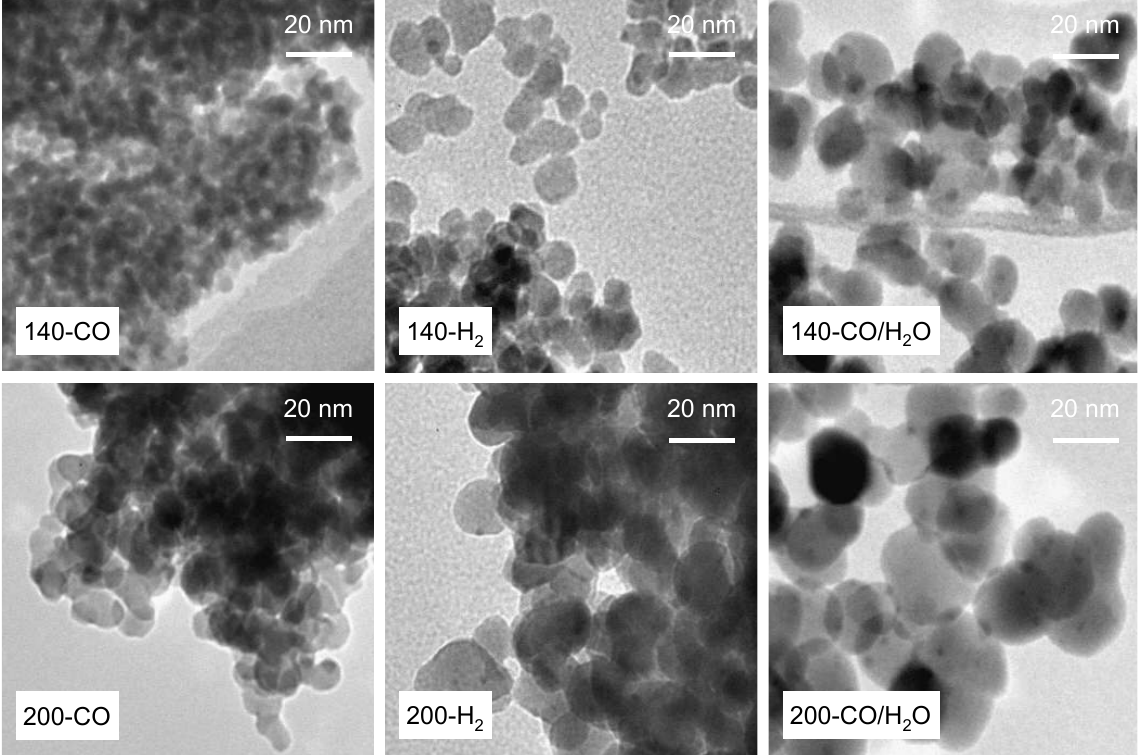
Figure 5. TEM photographs of the reduced